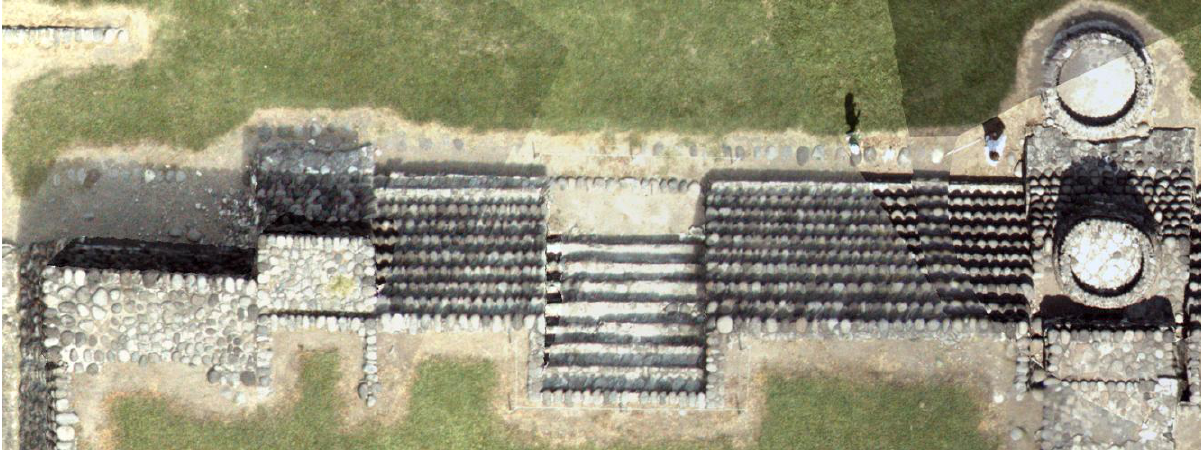
Figure 12. Detail of the orthophoto